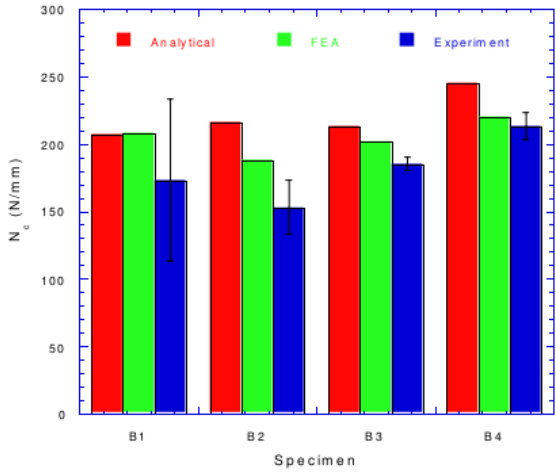
Figure 10: Comparision of critical buckling load from experiment, analytical (CLPT), and finite element eigen solution for sequences B1, B2, B3 and B4 shown in Table 4. Set target buckling load is 200N/mm.